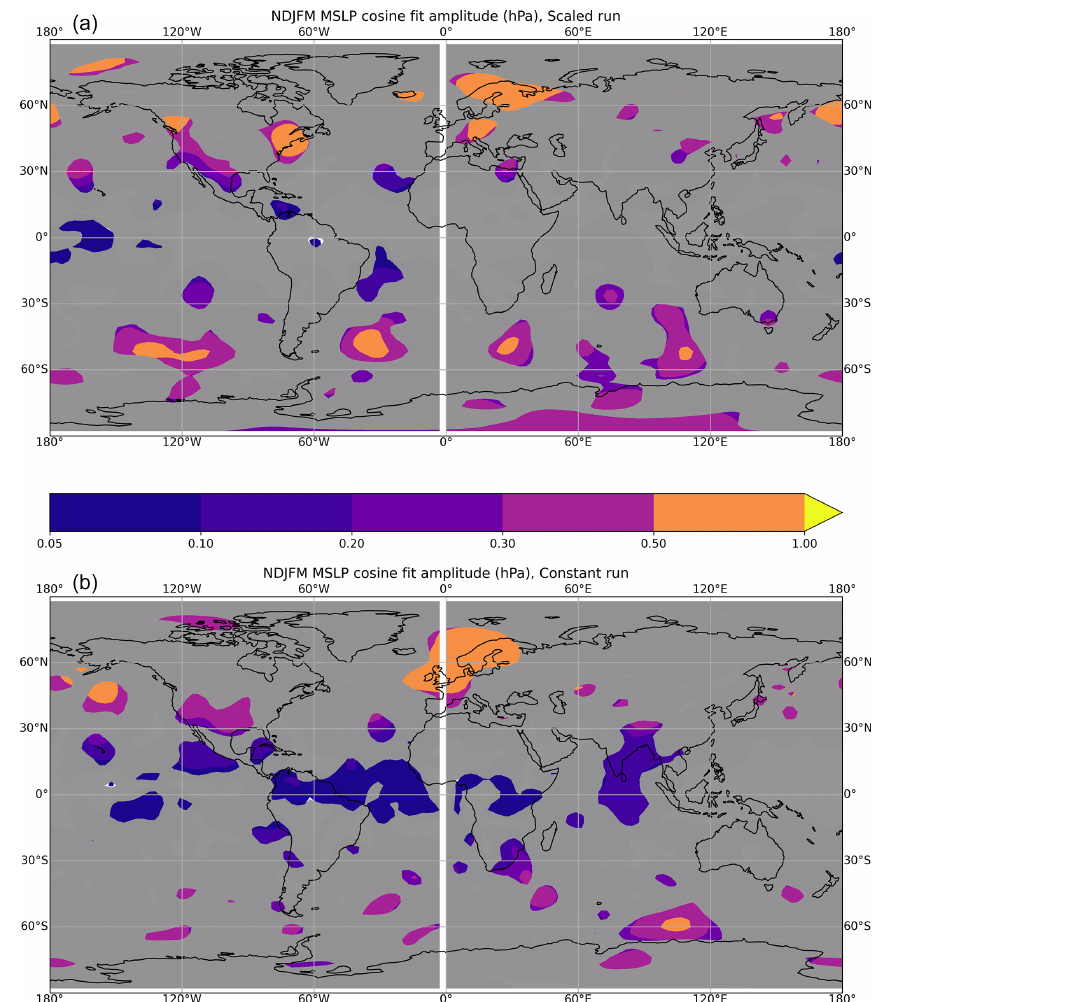
Figure 7. As Fig. 5 but for November–March (NDJFM) mean sea level pressure anomaly